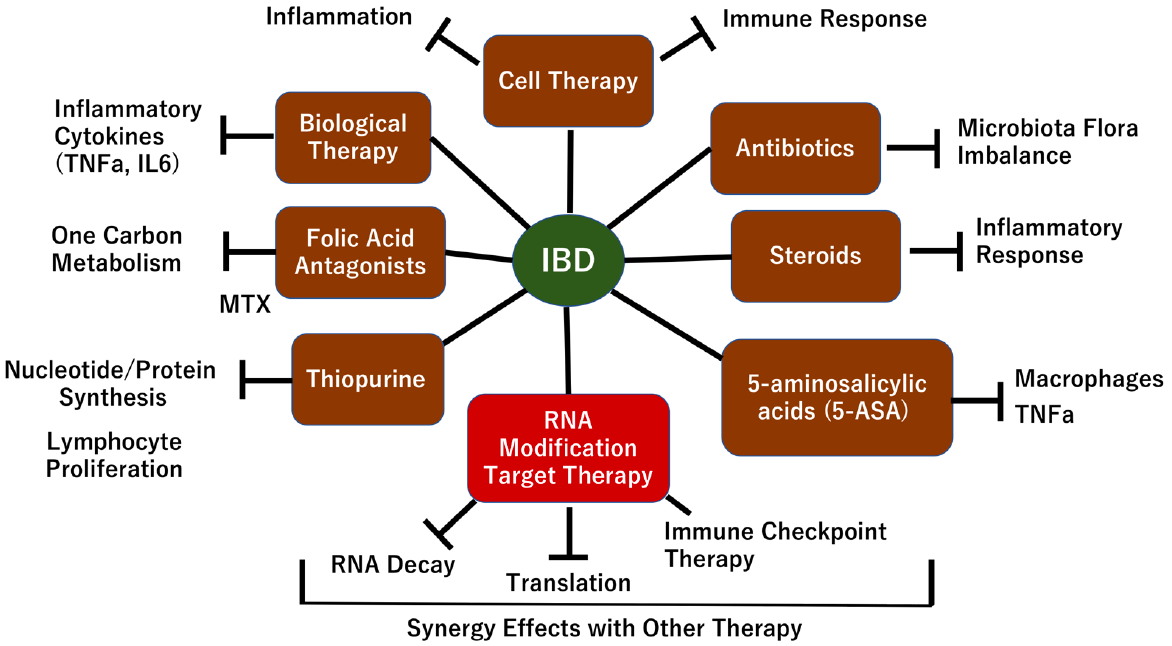
Figure 5. Therapeutic targets of RNA modifications in IBD. In IBD, several therapeutic approaches (e.g., biological therapy, folic acid antagonist, thiopurine, 5-aminosalicylic acids (5-ASA), and steroids) have been developed to treat inflammation to control the excess reaction of the inflammatory mechanism. To control bacterial flora, antibiotics are used to inhibit or reduce pathological organisms. Cell therapy may modulate the inflammatory response of IBD. RNA modifications can be targets for the IBD mechanism to regulate altered translation and RNA processing of splicing and decay in epithelial and immune cells, which will exert synergistic effects with immune checkpoint inhibitor therapy.